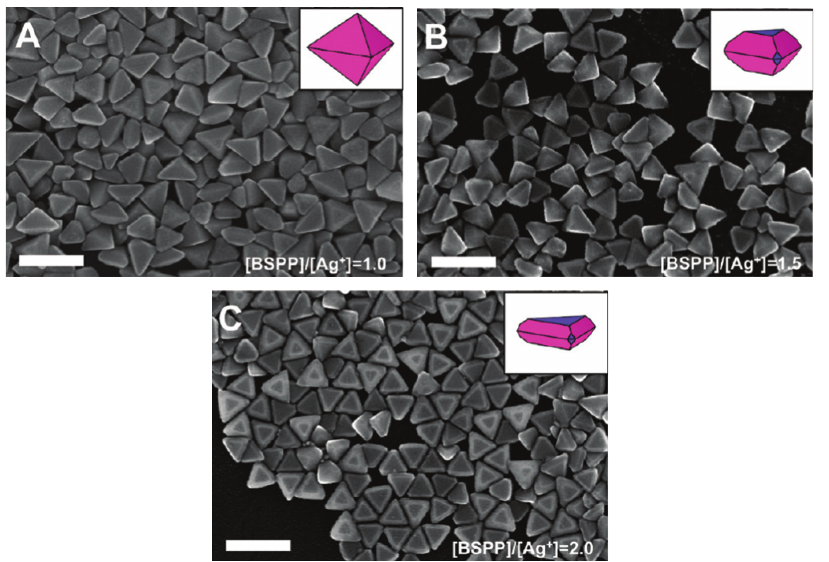
Figure 3 SEM images of silver nanoparticles, which were synthesized at pH 11 at various Ag+/BSPP ratios: (A) 1.0, (B) 1.5, and (C) 2.0. The scale bar corresponds to 200 nm. Reprinted with permission [2]. Copyright © 2010, American Chemical